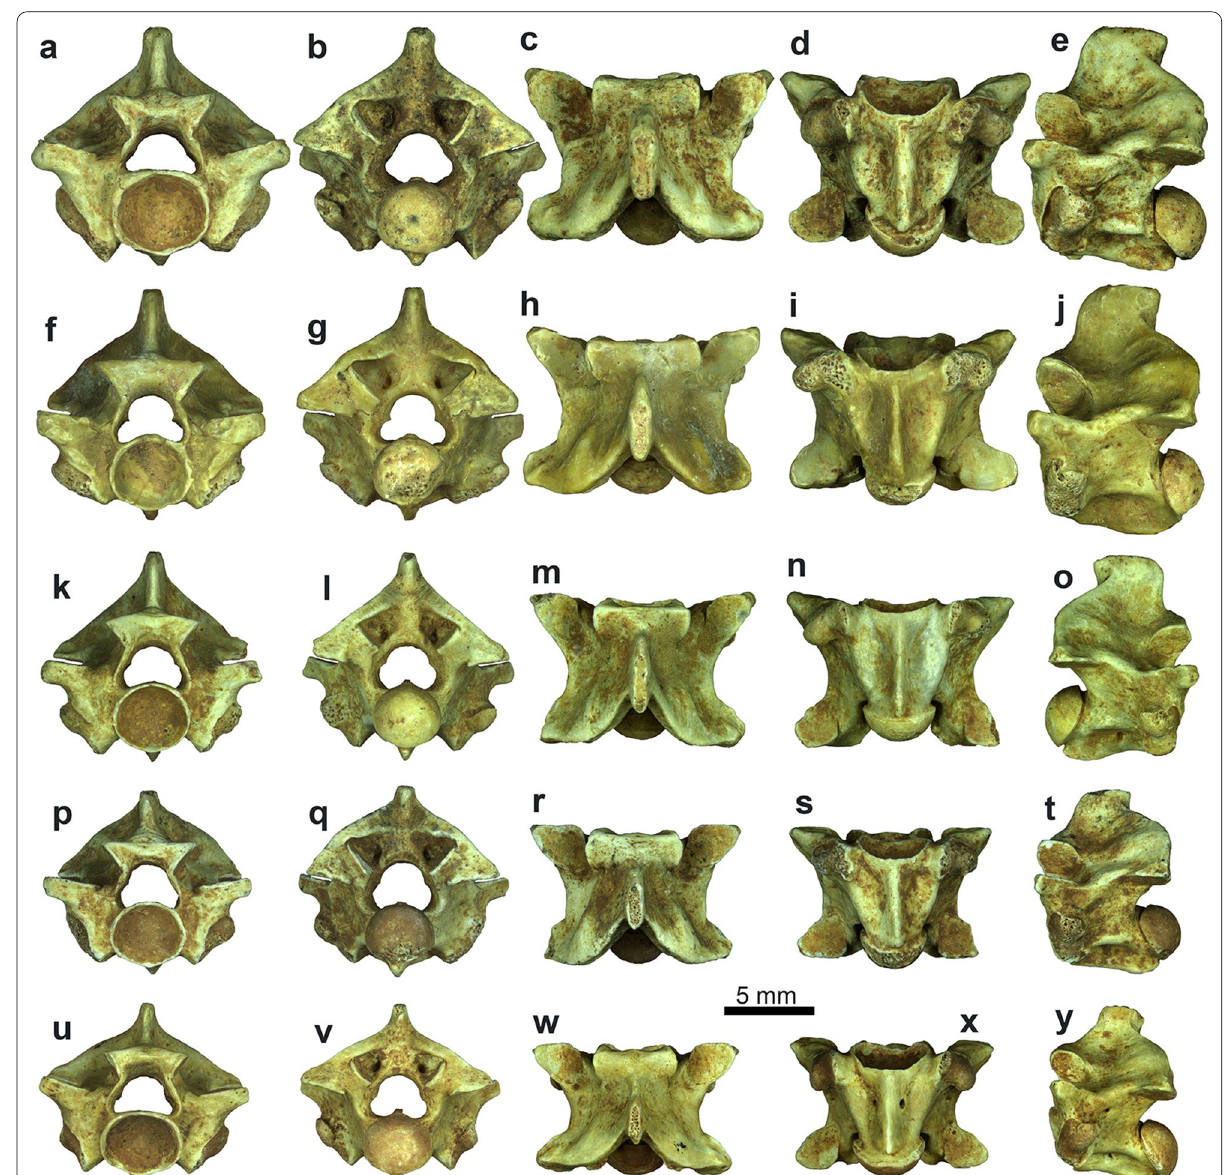
Fig. 86 Phosphoroboa filholii comb. nov. from imprecisely known locality(ies) in the Phosphorites du Quercy: a – e mid-trunk vertebra (NHMW 2019/0033/0049) in anterior ( a ), posterior ( b ), dorsal ( c ), ventral ( d ), and left lateral ( e ) views; f – j mid-trunk vertebra (NHMW 2019/0033/0122) in anterior ( f ), posterior ( g ), dorsal ( h ), ventral ( i ), and left lateral ( j ) views; k – o mid-trunk vertebra (NHMW 2019/0033/0150) in anterior ( k ), posterior ( l ), dorsal ( m ), ventral ( n ), and right lateral ( o ) views; p – t mid-trunk vertebra (NHMW 2019/0033/0078) in anterior ( p ), posterior ( q ), dorsal ( r ), ventral ( s ), and left lateral ( t ) views; u–y mid- to posterior trunk vertebra (NHMW 2019/0033/0149) in anterior ( u ), posterior ( v ), dorsal ( w ), ventral ( x ), and left lateral ( y )